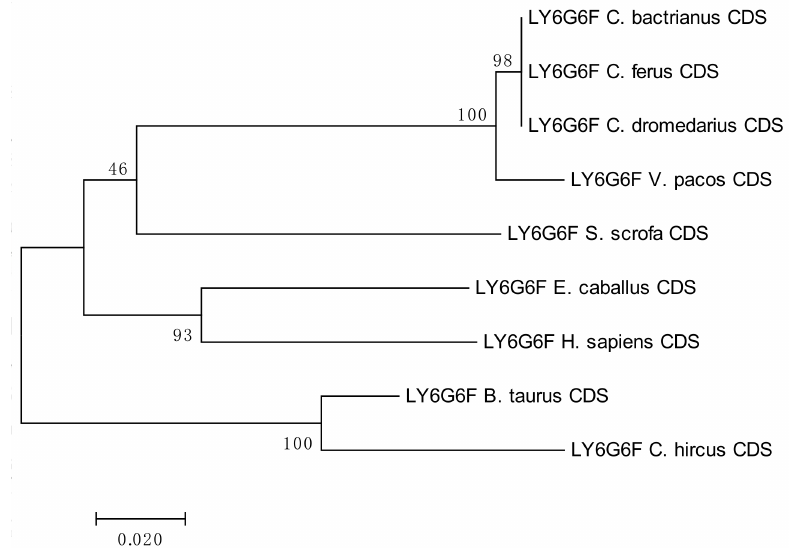
Figure 6. Phylogenetic tree of the LY6G6F CDSs from selected species. The maximum-likelihood method was used based on the Tamura 3-parameter model with gamma distribution (five categories, parameter = 0.8816). The number of bootstraps was